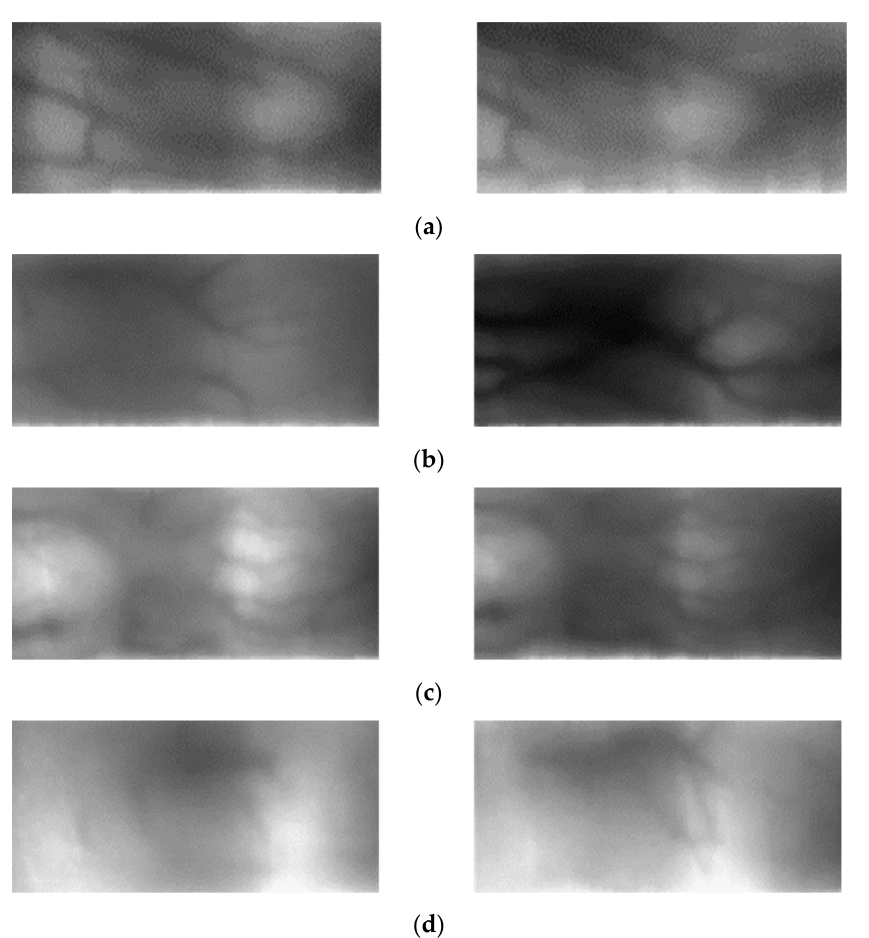
Figure 12. Examples of errors in case of testing with HKPolyU-DB: ( a ) False rejection case by both proposed method and no domain adaptation, ( b ) false acceptance case by both proposed method and no domain adaptation, ( c ) false rejection case by the no adaptation method, but correct recognition case by the proposed method, ( d ) false acceptance case by the no adaptation method, but correct rejection case by the proposed method. Left and right images of ( a – d ) show enrolled and matched images, respectively.